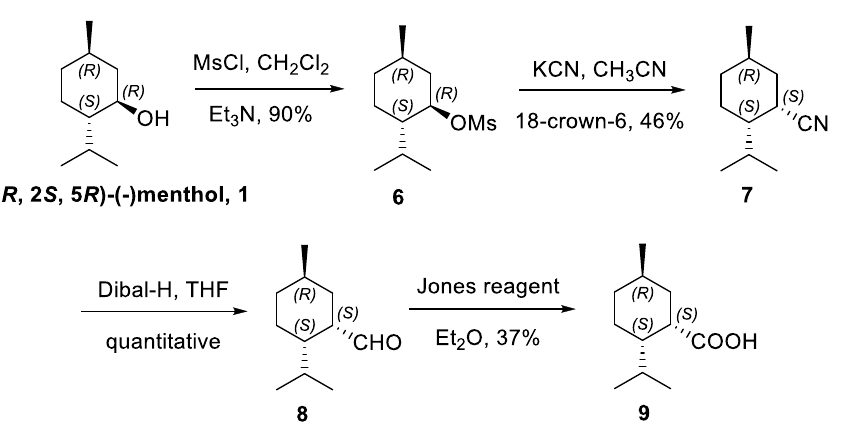
Figure 1. Structure and configuration of the target compounds in this work.